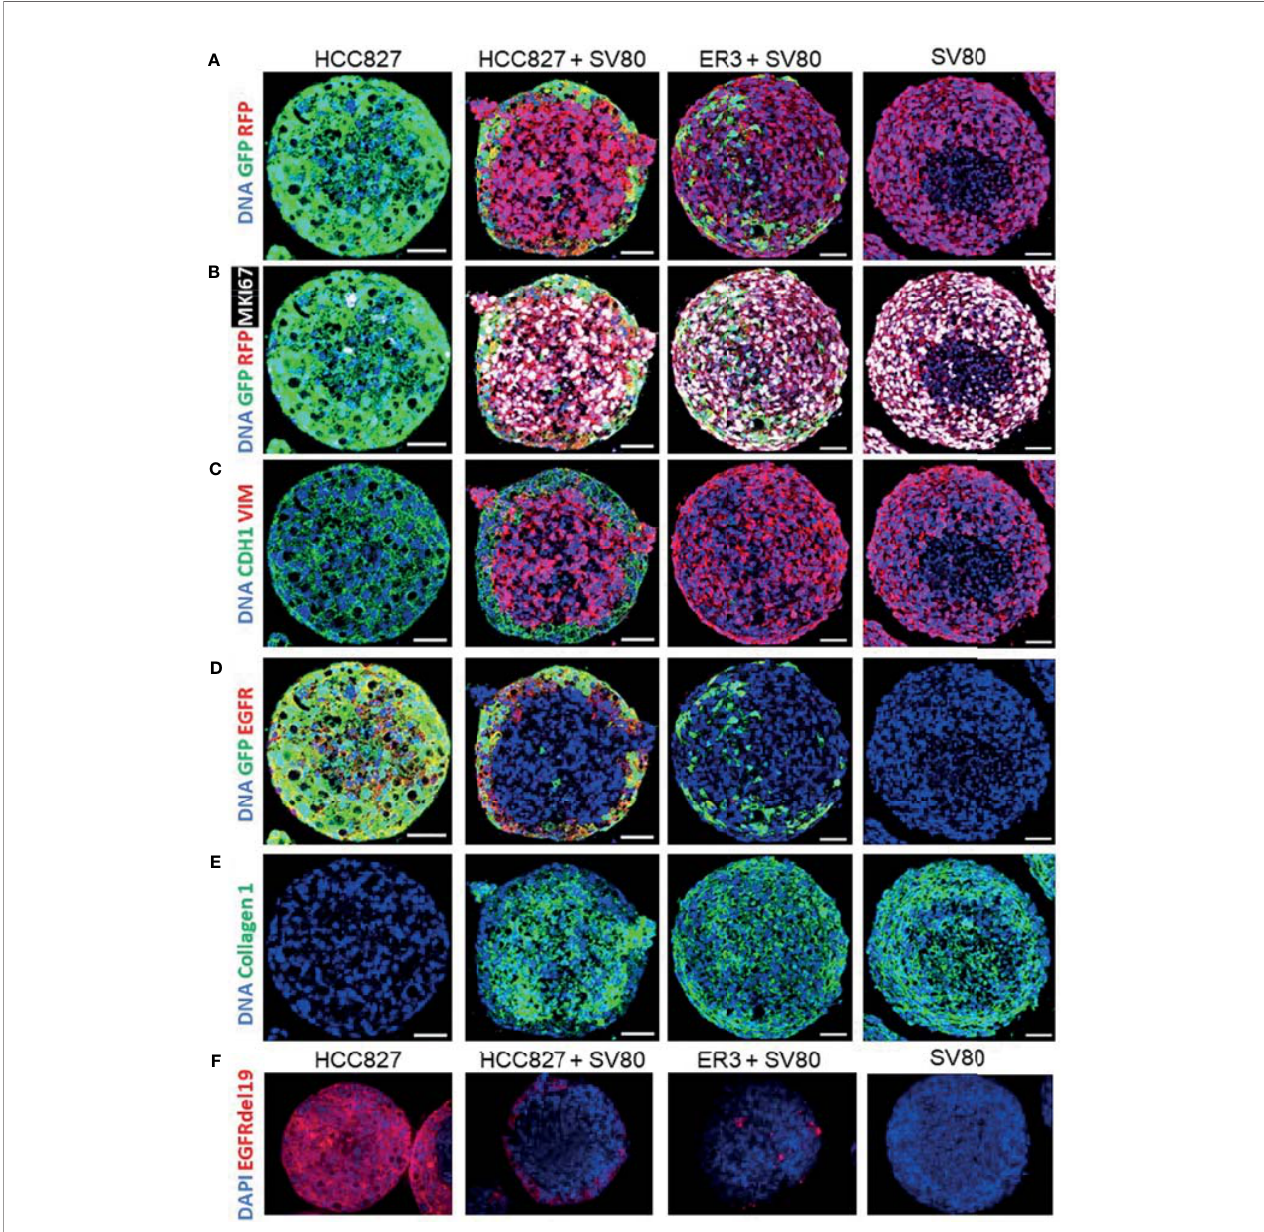
FIGURE 6 | Characterization of spheroids using immunohistochemistry with fl uorescent detection and imaging mass cytometry. HCC827-GFP monoculture, HCC827-GFP + SV80-dsRed co-culture, ER3-GFP + SV80-dsRed co-culture, and SV80-dsRed monoculture spheroids were stained with an imaging mass cytometry panel of 14 heavy metal-tagged antibodies ( Table 3 ). For each condition, fi ve ROIs containing a single spheroid were ablated by a Hyperion imaging mass cytometer (Fluidigm, Inc.). Representative ROIs are displayed showing (A) GFP and RFP, (B) GFP, RFP and MKI67 (Ki67), (C) CDH1 (E-cadherin), and VIM (Vimentin), (D) GFP and EGFR, (E) and Collagen 1. DNA staining displayed in all images is a combination of Iridium intercalator stain (Ir191 and Ir193) and Histone H3. Images were pseudo-colored in MCD viewer software (Fluidigm) to enable visualization of multiple channels per ROI, and for each channel the minimum and maximum intensity display settings are manually set to be kept constant between the samples. Scalebar = 50 µm (F) Immunohistochemistry staining with the EGFRdel19 mutation-speci fi c antibody and AF647 fl uorescence tagged secondary antibody together with DAPI counterstain. Fluorescent images were taken with a Zeiss Collibri7 fl uorescence